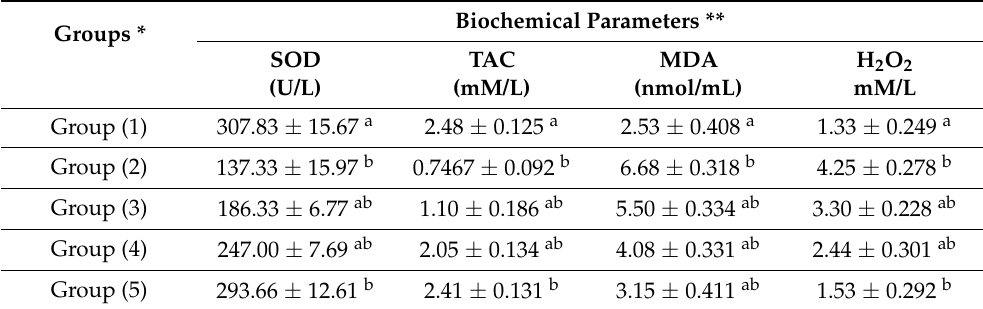
Table 2. Concentrations of bone tissue oxidative stress parameters and antioxidant biomarkers in the control and treatment